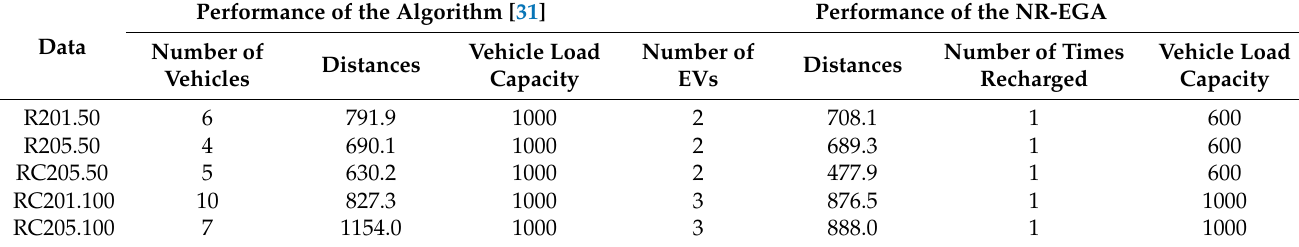
Table 4. Performance comparison.